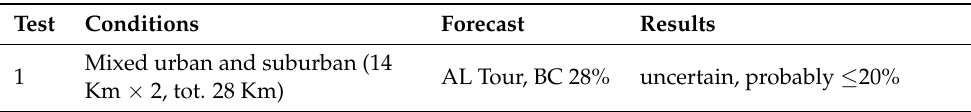
Table 3. Second set summary with Pegasus Premio 10 Lite (legend: AL is Assist Level, BC is Battery